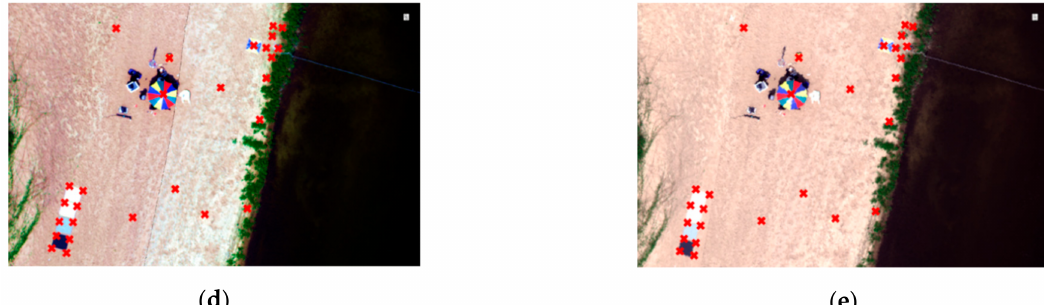
Figure 12. Datasets for verification: ( a ) 128 corners extracted from the RGB image used as ground truth; ( b ) RGB orthogonal image expanded from the area marked in red for qualitative comparison; ( c ) corners indicated in the image for which just georeferencing was applied; ( d , e ) image registration results achieved using the displacement measured by applying template matching and optical flow techniques, respectively.